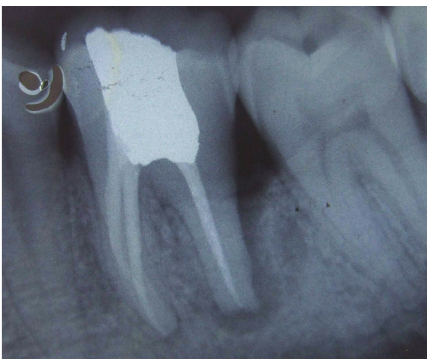
Figure 4: Six-month follow-up.